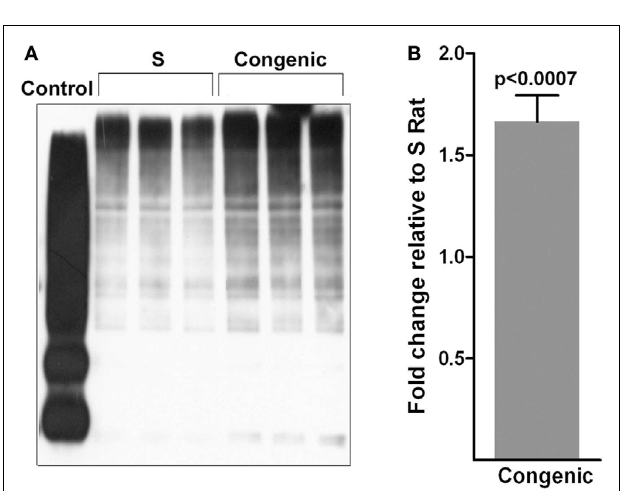
FIGURE 5 | Polyubiquitination of proteins. (A) Immunoblot of polyubiquitinated proteins in whole-cell lysates from S ( n = 3) and congenic ( n = 3) rat kidneys. Control is from the Pierce ubiquitination kit. (B) Quantification of the blot shown in (A) by